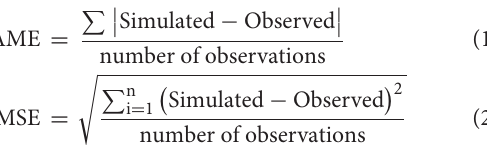
dissolved oxygen (DO), chlorophyll a (Chl.a), and phytoplankton species and biomass.